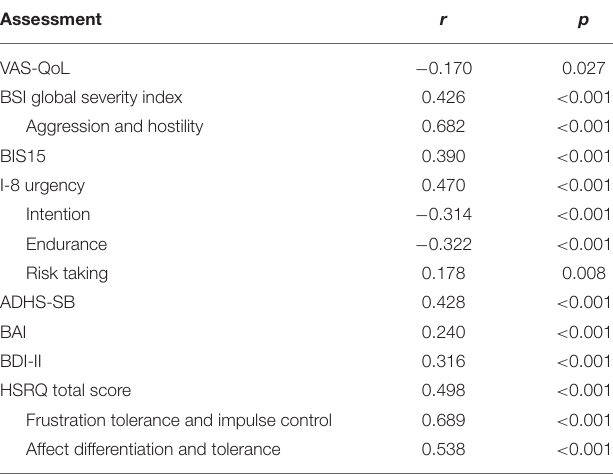
TABLE 2 | Pearson correlations r between RAQ-R and other